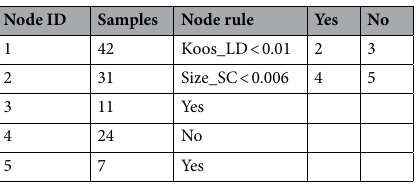
Classification accuracy (ACC) for test set Feature selection method